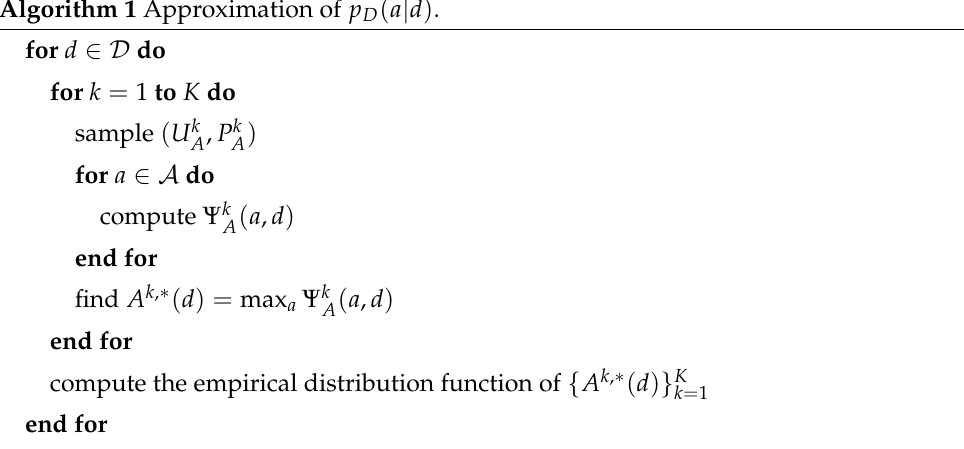
Algorithm 1 Approximation of p D ( a | d )